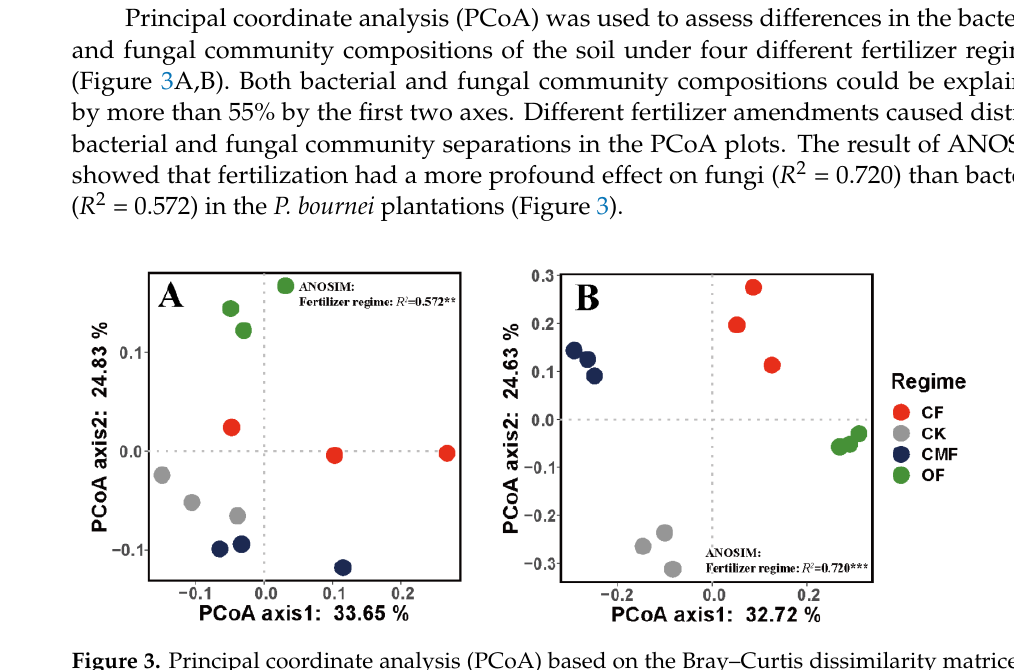
Figure 4. Venn diagram of the number of shared and unique OTUs under the different fertilization treatments in soil bacterial ( A ) and fungal communities ( B ). OTUs are defined at 97% sequence sim- ilarity. CK, control; CF, compound fertilizer; OF, organic fertilizer; CMF, compound microbial fer- tilizer. 3.6. Main Driving Factors of Taxonomic and Functional Compositions of Soil Microbial Community Partial Mantel tests were performed to determine the distance-corrected differences between soil microbial community compositions and soil variables (Figure 5). Unexpect- edly, root exudates (e.g., αCop, Cal, Fur.) had a strong effect on soil bacterial community composition instead of soil physiochemical properties (Figure 5). In contrast, soil fungal